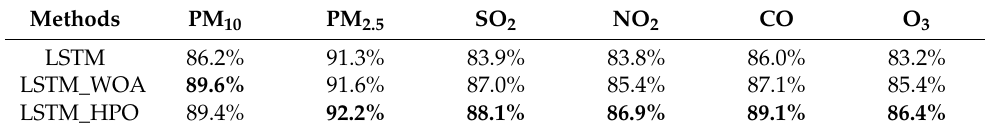
Table 15. The accuracies of the LSTM_HPO compared with LSTM and LSTM_WOA in dataset 2.